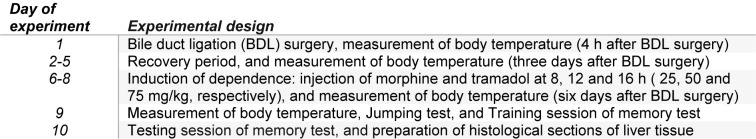
This table clarifies the experimental design.